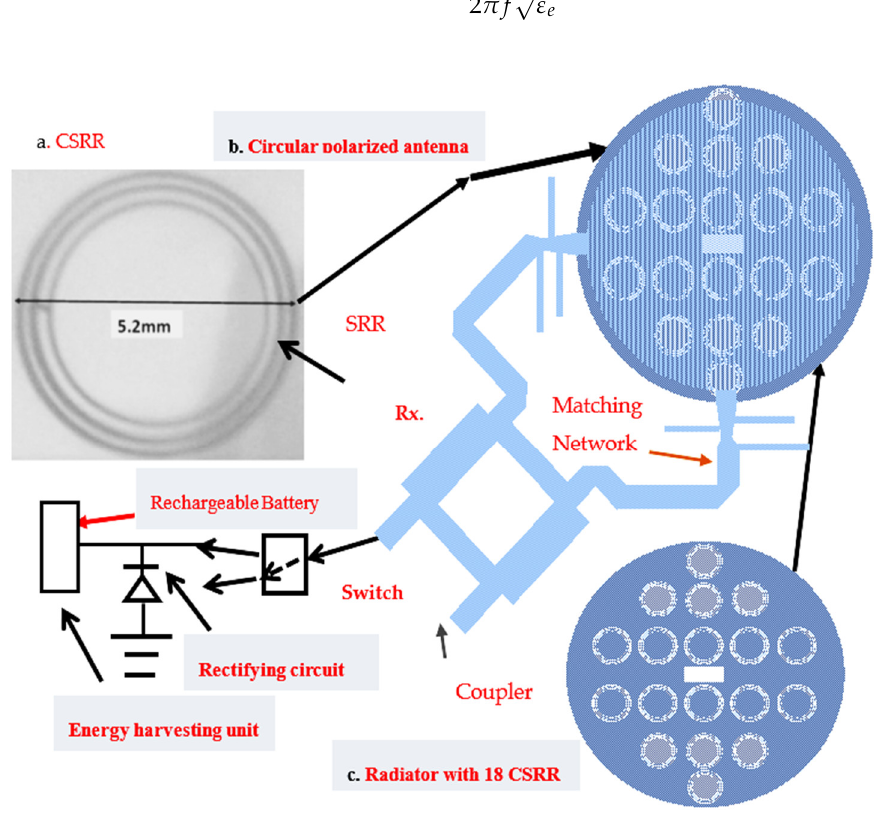
Figure 1. ( a ) Single CSRR ( b ) Circular polarized sensor and harvester. ( c ) The radiator.